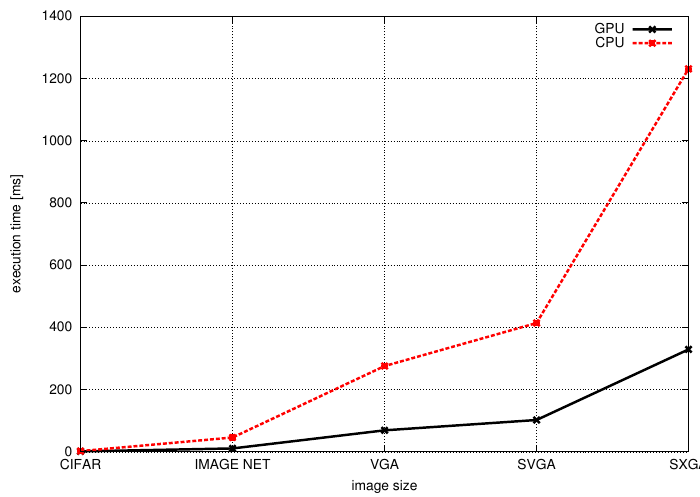
Figure 10. Max pooling operation performance on the mobile device as a function of the input image size.